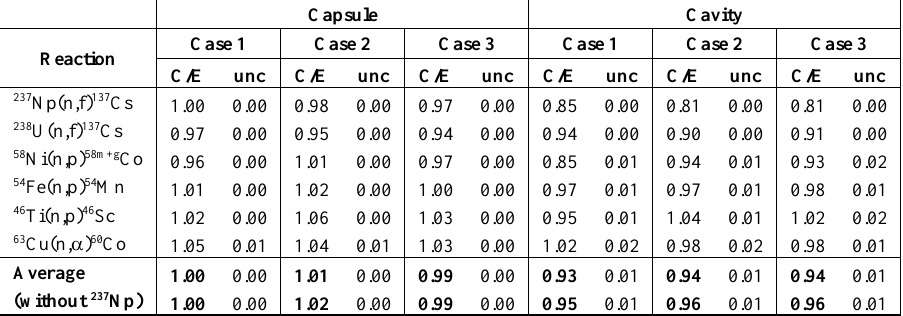
Table 5 : C/E ratios of activities at End-of-Irradiation (EoI) in HBR-2 benchmark. Averages report sample standard deviations only. Uncertainties below 0.5 % read